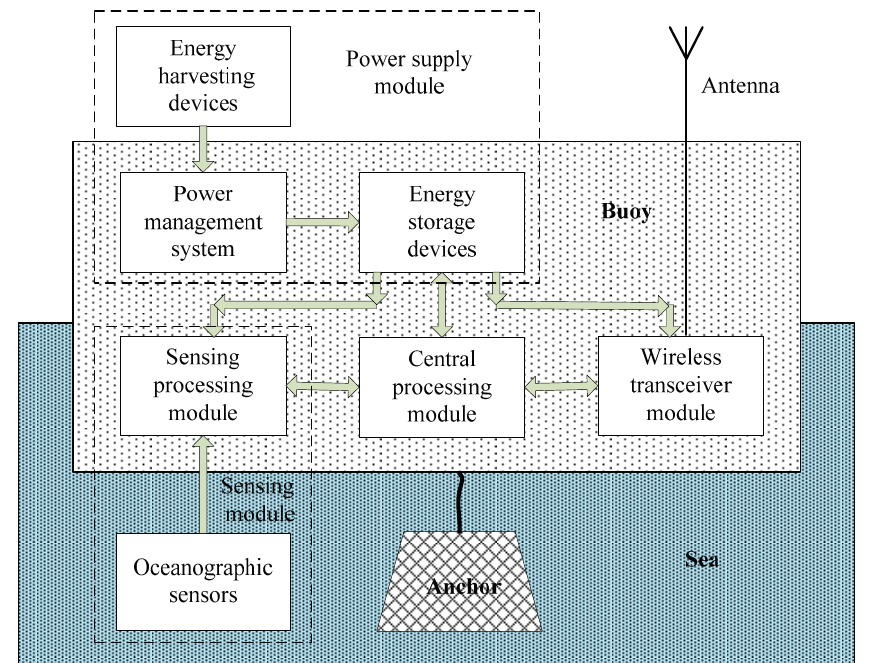
Figure 2. General architecture of an oceanographic sensor